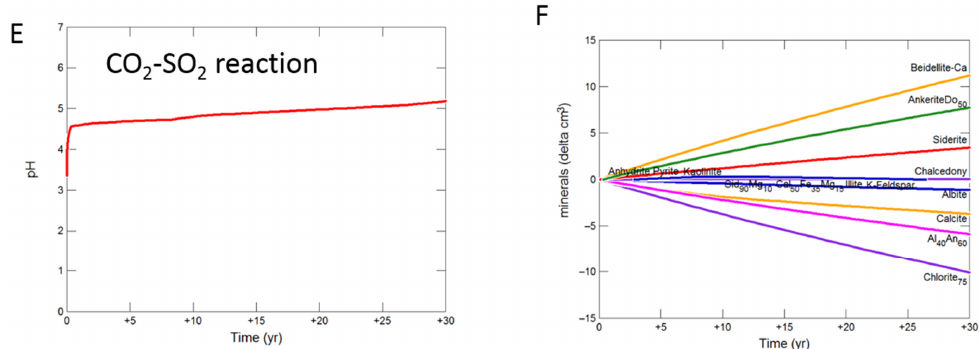
Figure 9. Up-scaled mudstone cap-rock reaction over 30 years. Reaction with CO 2 -SO 2 -O 2 ( A ) predicted pH; ( B ) predicted change in mineral volumes (delta cm 3 ) where positive values indicate precipitation, and negative values dissolution; Reaction with CO 2 ( C ) predicted pH; ( D ) predicted change in mineral volumess; Reaction with CO 2 -SO 2 ( E ) predicted pH; ( F ) predicted change in mineral volumes.